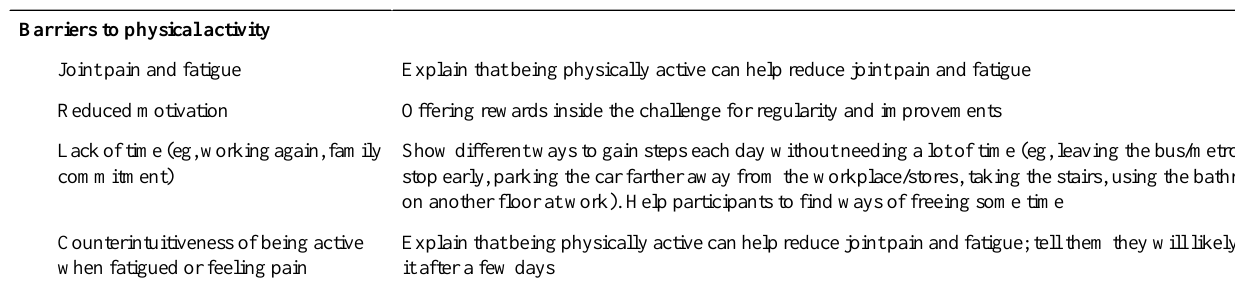
Table 4. Solutions to reduce barriers.